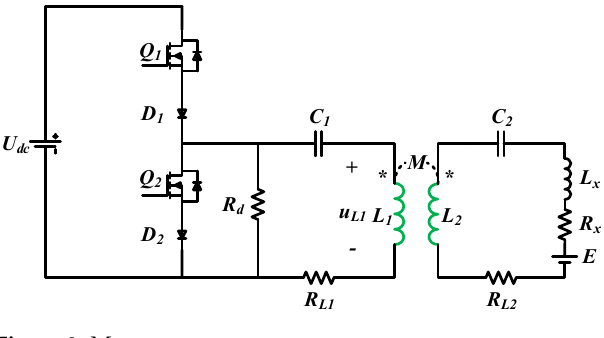
Figure 2. Measurement system.